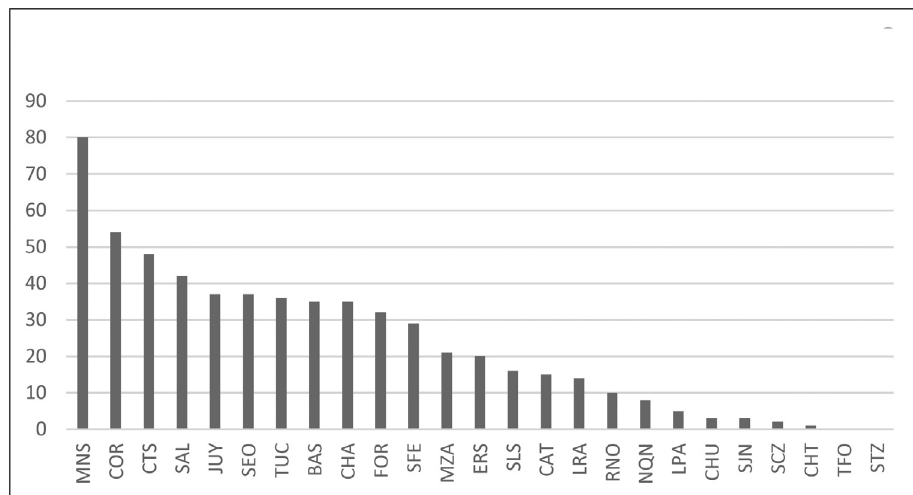
Figure 37. Bars diagram showing species by provinces, it can be observed that species richness diminished through southern provinces.